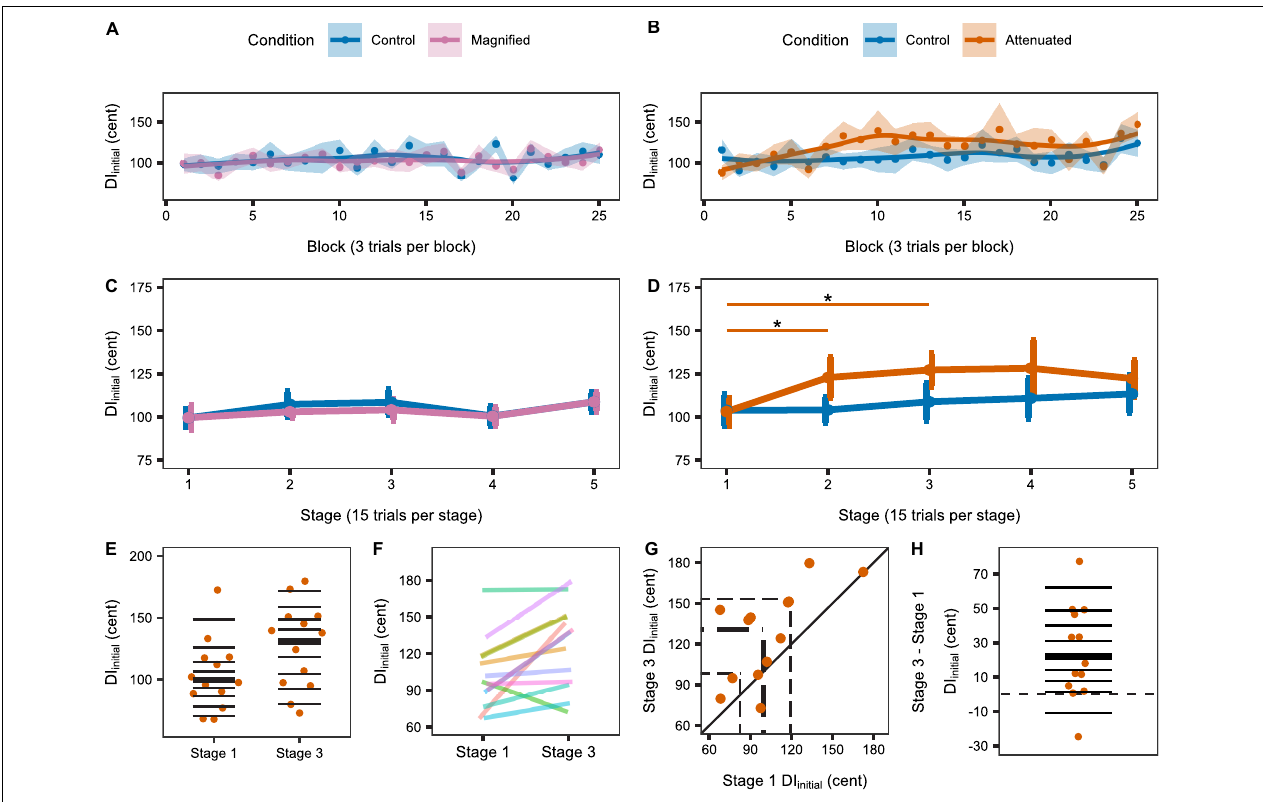
FIGURE 4 | (A,B) Change in DI initial across the Variability task by block (i.e., 3 trials) for the Magnified and Attenuated feedback variability conditions. Dots represent the group mean DI per block. Shaded regions indicate standard error of the mean (SEM). Solid lines are loess smoothed fits (span = 0.6). (C,D) Change in DI initial across the Variability task by stage (i.e., 15 trials) for the Magnified and Attenuated feedback variability conditions. Error bars indicate SEM. Asterisks indicate adjusted p < 0.05 (see Table 1 ). (E–H) Individual participant data for the significant change from Stage 1 to Stage 3 in the Attenuated condition: (E) Stripchart of DI initial in Stage 1 and Stage 3. Horizontal lines indicate deciles; bold line is the median. (F) Stripchart with each participant’s Stage 1 and Stage 3 data linked. (G) Scatterplot of Stage 1 by Stage 3 data. The diagonal line denotes no difference between stages. Participants in the upper left half increased DI initial in Stage 3. Dashed lines mark quartiles. (H) Stripchart of the difference in DI initial between Stage 3 and Stage 1. Horizontal lines indicate deciles; the bold line is the median; the dashed line is at zero (no difference between